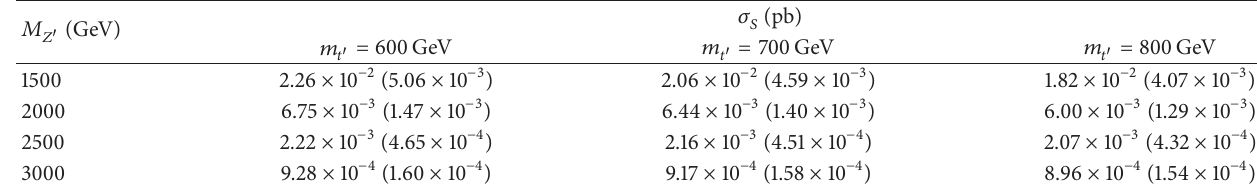
Table 4: The same as Table 3, but for 𝑥 = 0.05 .